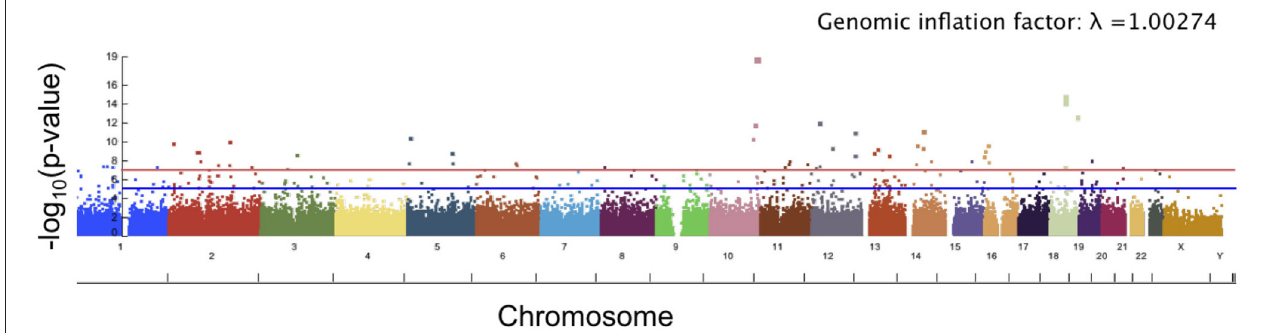
FIGURE 7 | Manhattan plot showing significance of the relationship between each SNP and our angle of surface orientation score. The red line corresponds to a threshold of genome-wide significance of p = 5 × 10 − 8 and the blue line corresponds to a threshold of suggestive significance p = 1 × 10 − 5 .